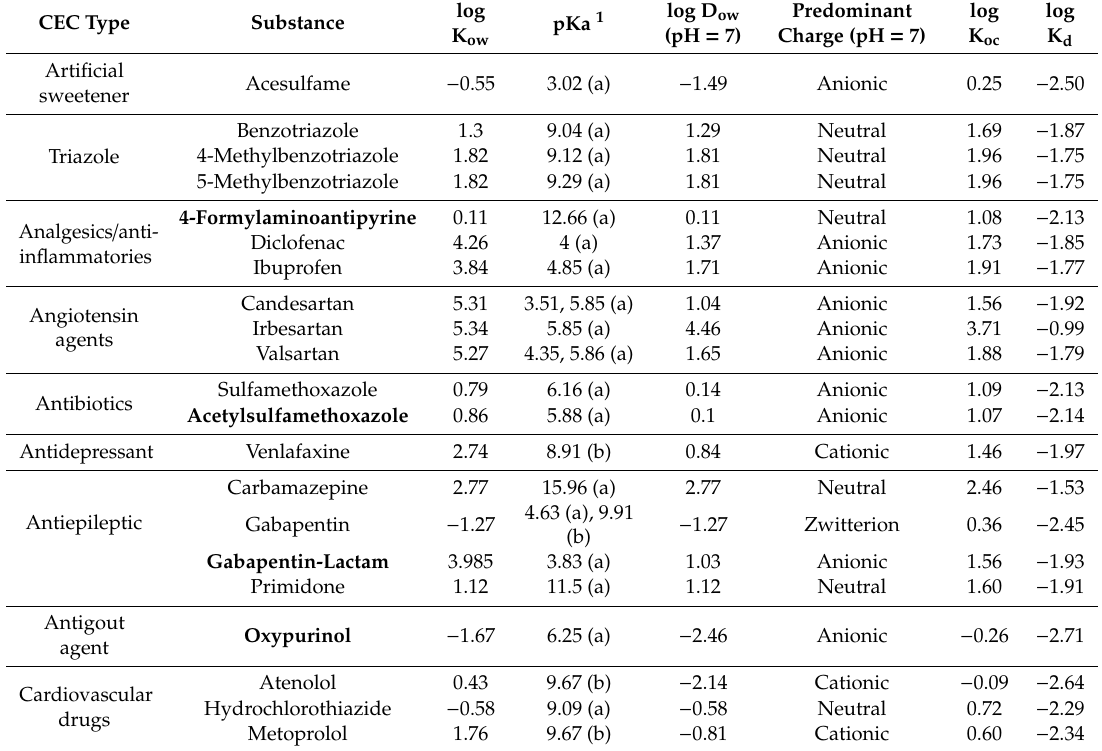
Table 4. Target CECs and their physicochemical properties. Log K ow , acidity constant (pka) and